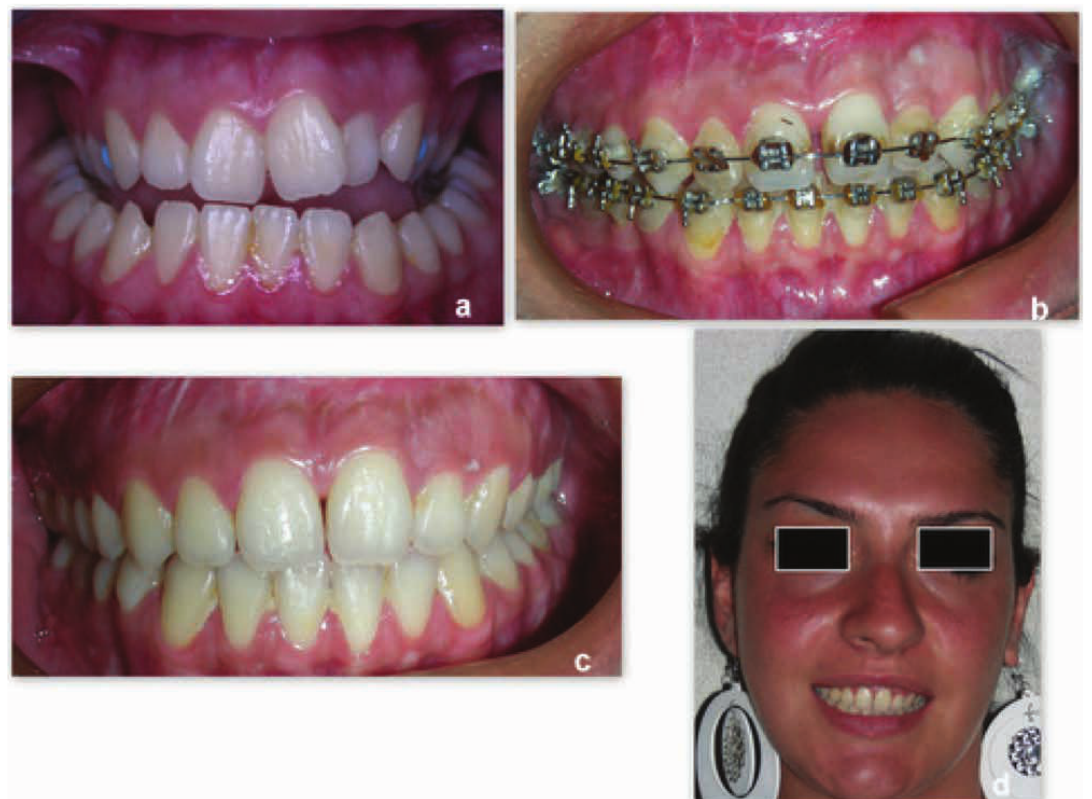
Figure 3: Case 3 upper jaw surgery (table 2) a) Pre-operative oral view; b) Oral view during orthodontic treatment; c) Oral view at 2 years post treatment; d) Extraoral view at 2 years post treatment